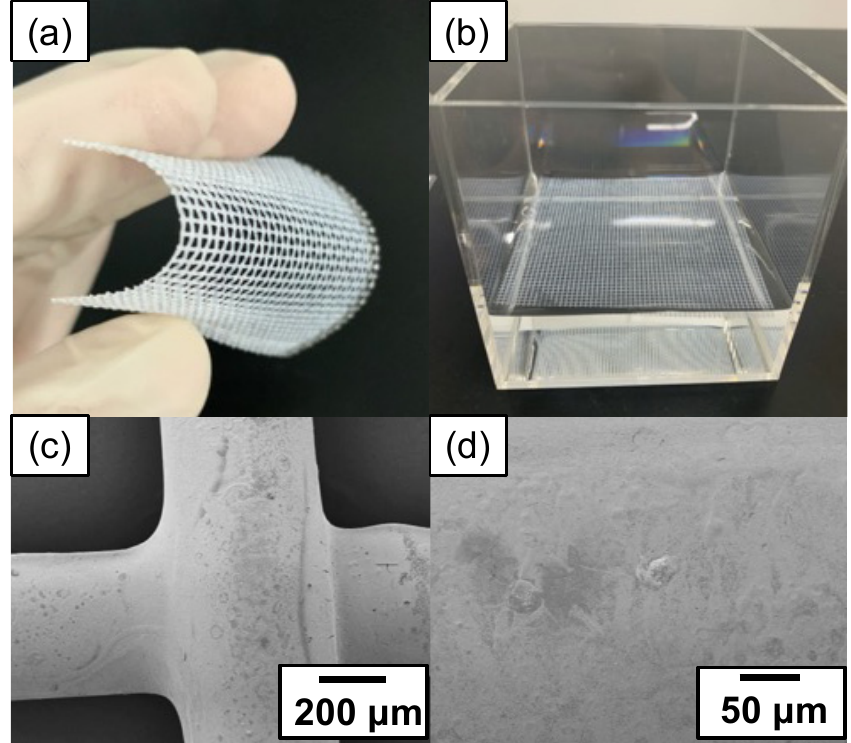
Figure 2. Photographs of ( a ) a bent TiO 2 net and ( b ) a net floated on water. ( c , d ) SEM images of the TiO 2 net surface at different magnifications.